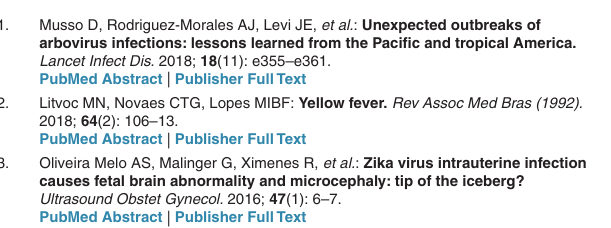
Table S1. YFV reference strains information,